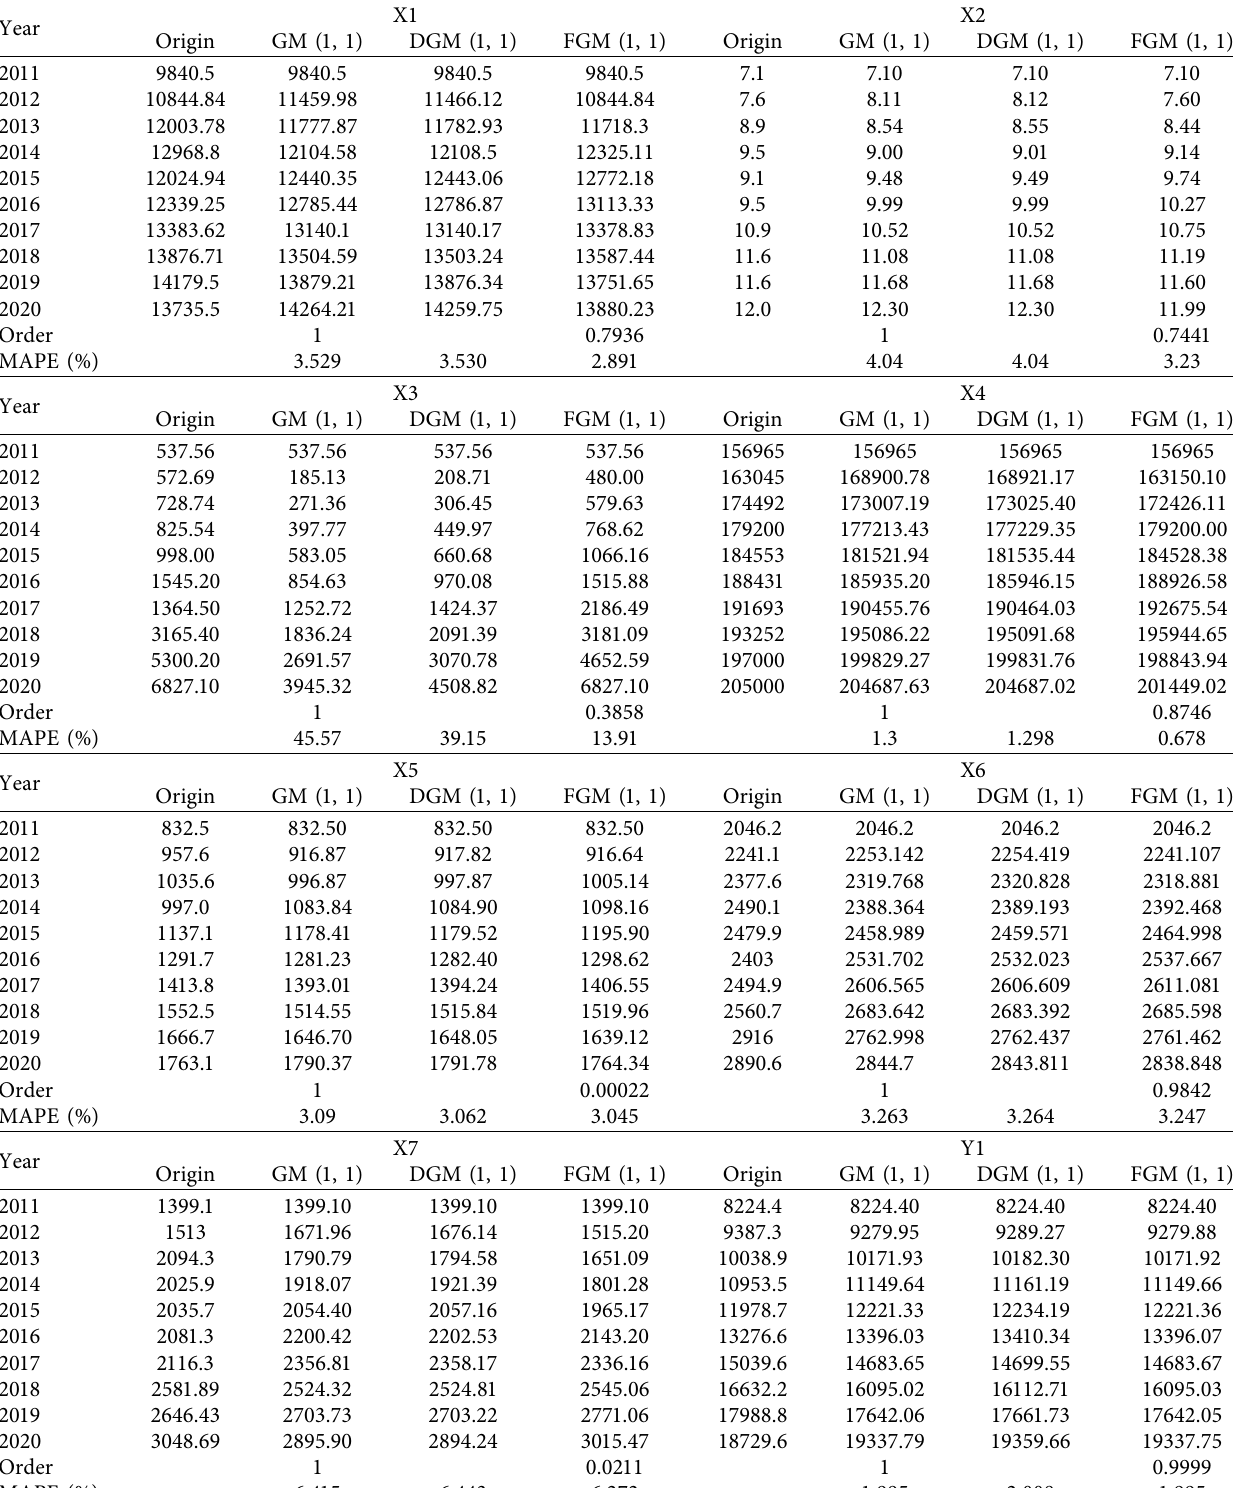
Table 9: Fitting values and errors of economic and logistic